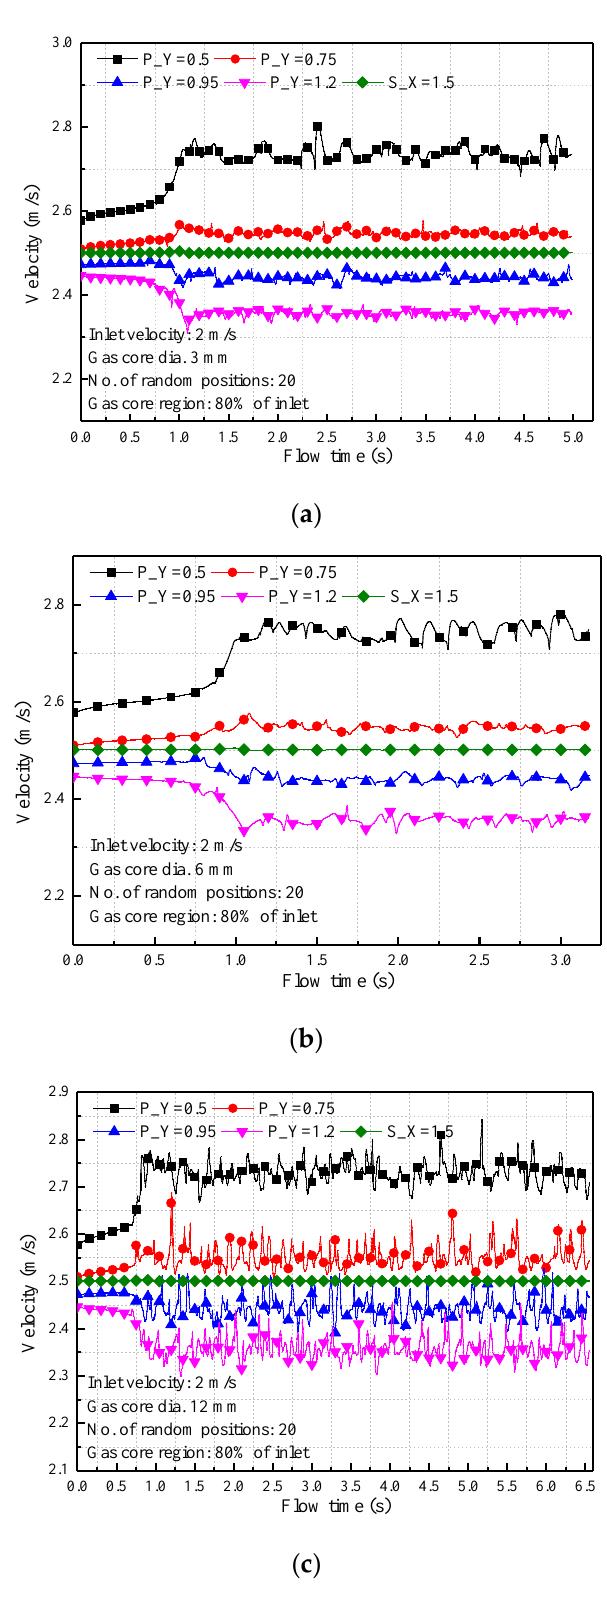
Figure 3. Instantaneous velocity at four locations [(1.5, 0.5), (1.5, 0.75), (1.5, 0.95), and (1.5, 1.2)] and an average surface velocity measured at x = 1.5 m. Effects of bubble diameter on bubble–liquid flow velocity fluctuation, with gas charging length, d, of ( a ) 3, ( b ) 6, and ( c ) 12 mm, and the corresponding generated bubble size was 2.76, 3.91 and 5.53 mm,